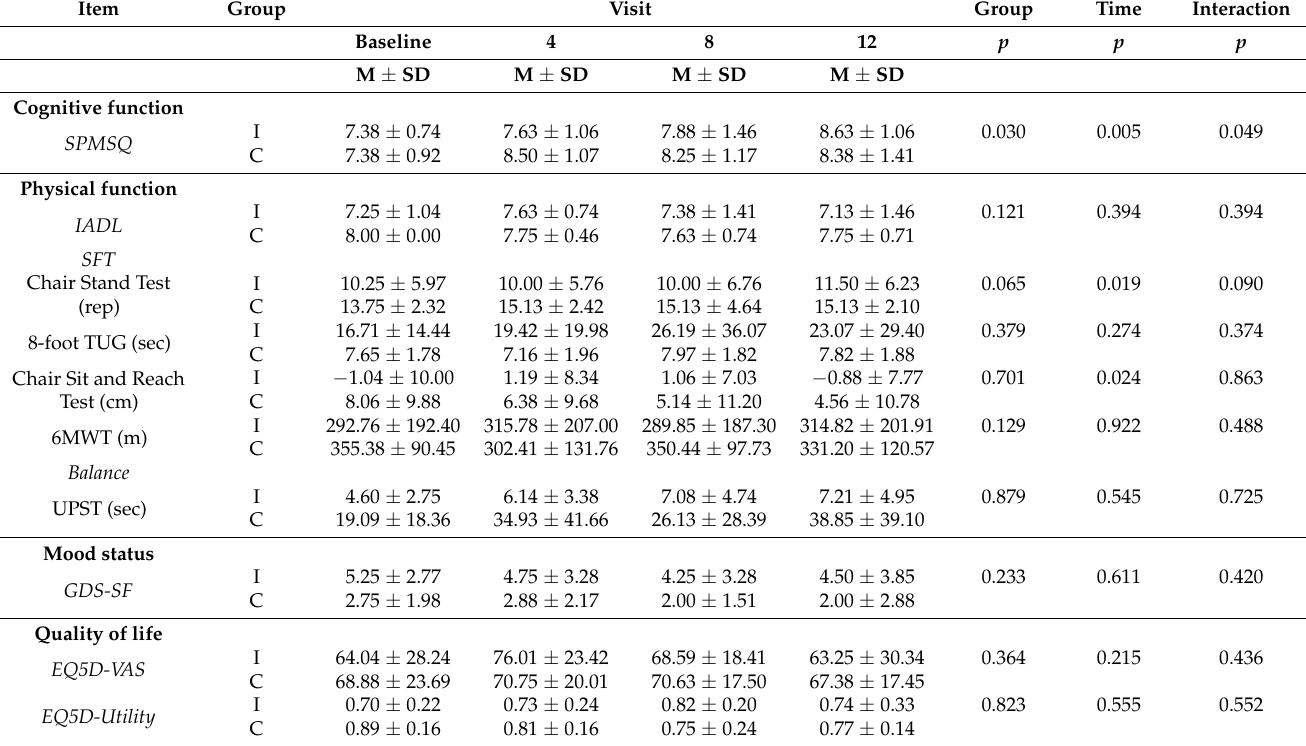
Table 4. GEE Models between groups for cognitive function, physical function, mood status, and quality of life by group, time, and group-by-time interaction: Baseline to 12